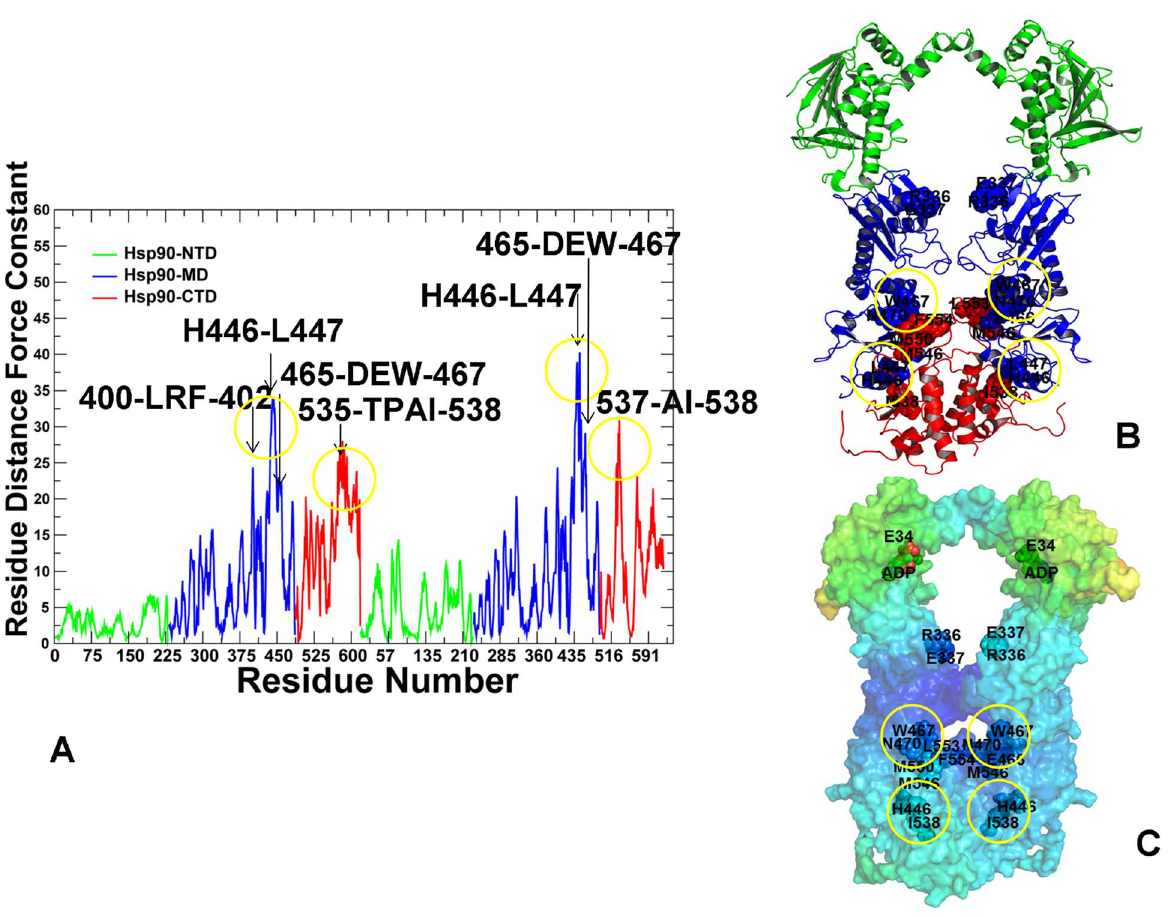
Figure 5. The Force Constant Stability Analysis of the ADP-bound HtpG Chaperone. (A) The residue-based force constant profile of the ADP-bound HtpG structure. The NTD residues are in green, MD residues are in blue, and CTD residues are in red. The residue-based dynamic profiles are annotated using the residue numbering in the original crystal structure [56]. The peaks of the force constant profiles corresponding to functionally important residues are indicated by arrows and annotated. Functional residues corresponding to the peaks in the force constant distribution are mapped onto the domain-colored crystal structure of ADP-HtpG (B) and onto the functional dynamics profile of ADP-HtpG (C). Functional residues are annotated and shown in spheres and colored as in Figure